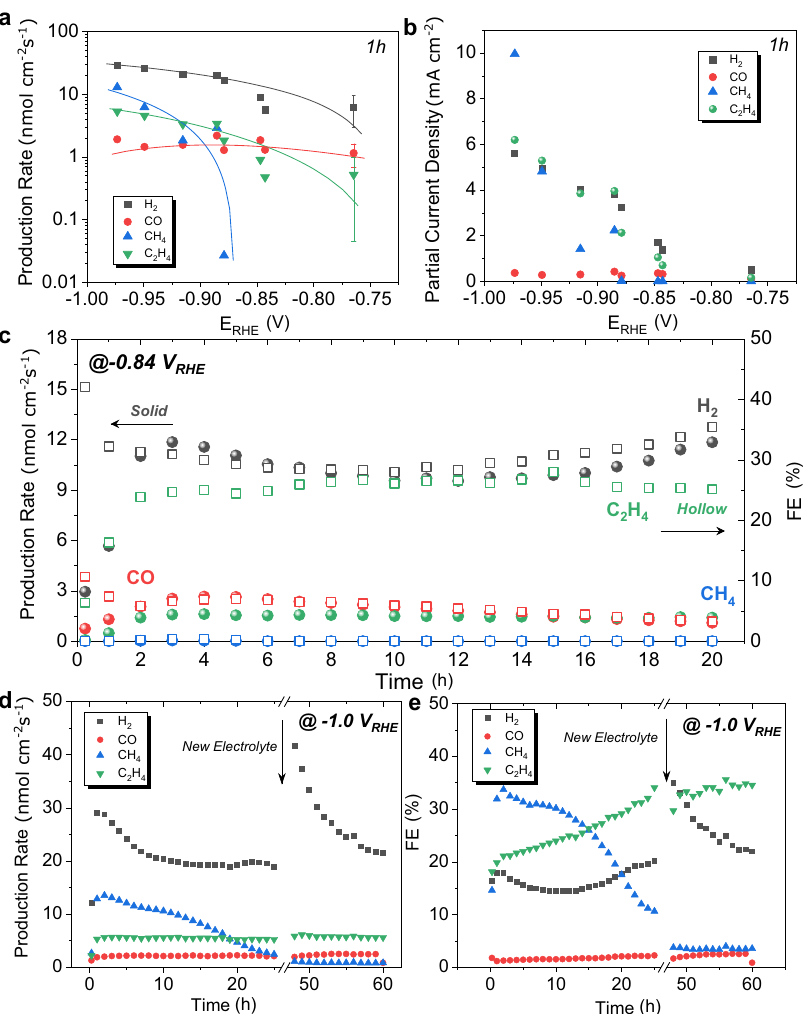
Fig. 2 Electrocatalytic CO2RR tests using CuO NS in H-cells. a Absolute product formation rates of major gaseous products as a function of applied electrode potentials during CO2RR in CO 2 -saturated 0.1 M KHCO 3 at 60 min. b Partial current densities as a function of applied electrode potentials during CO2RR in CO 2 -saturated 0.1 M KHCO 3 at 60 min. c Chronoamperometric performance stability of the CO 2 reduction reaction on CuO NS in CO 2 -saturated 0.1 M KHCO 3 at − 0.84 V RHE . d and e Long-term stability test over 60 h for d absolute product formation rates of major gaseous products and e Faradaic ef fi ciencies on CuO NS in CO 2 -saturated 0.1 M KHCO 3 at − 1.0 V RHE . The error bars are given as standard error of mean. Catalyst loading: 100 μ g cm − 2